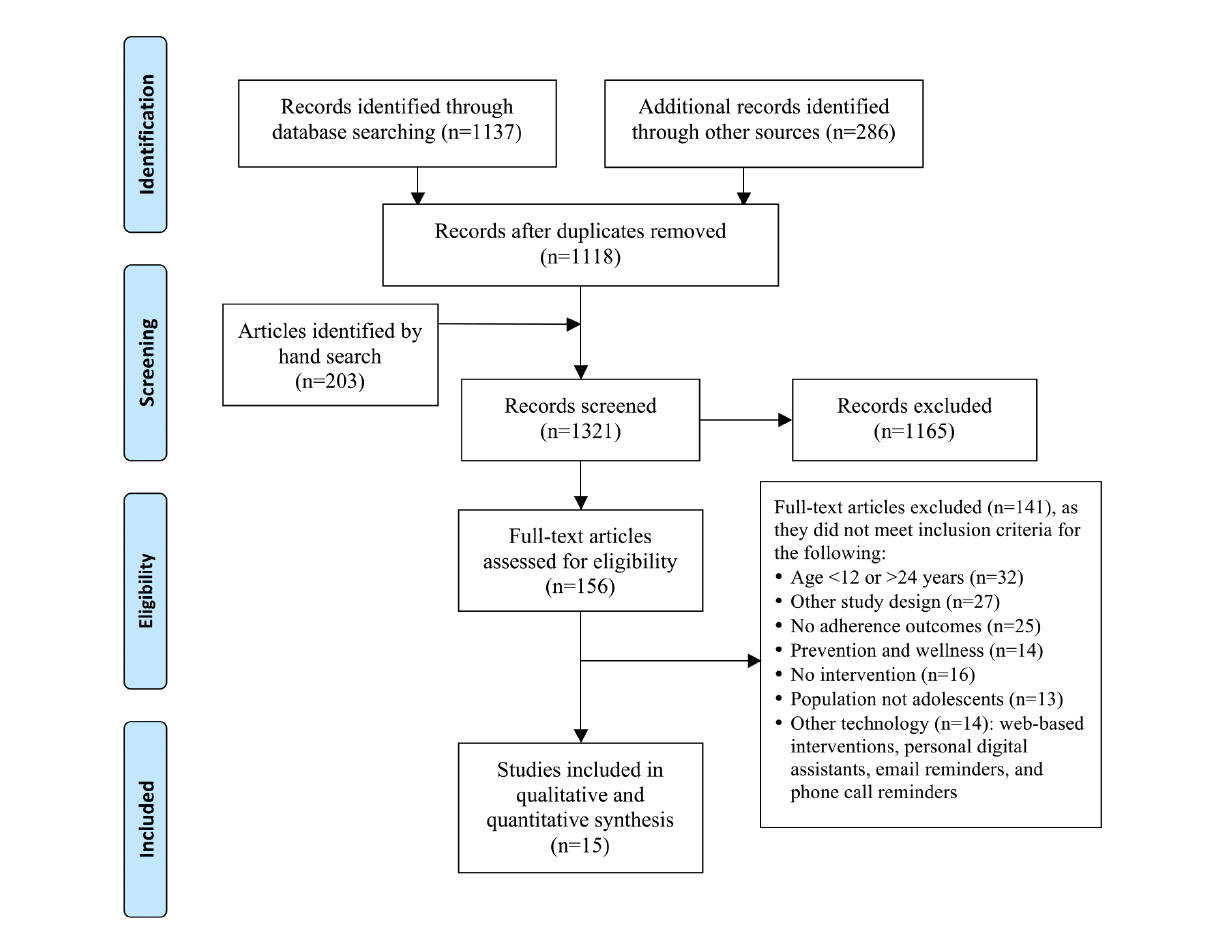
Figure 1. Flow of studies through the review according to PRISMA